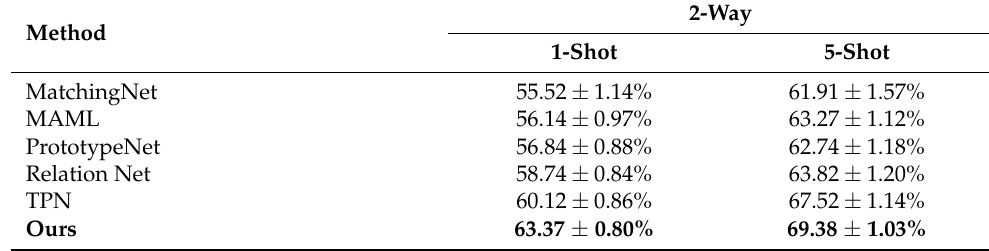
Table 2. The accuracy comparison of different methods on the DermaMNIST dataset.